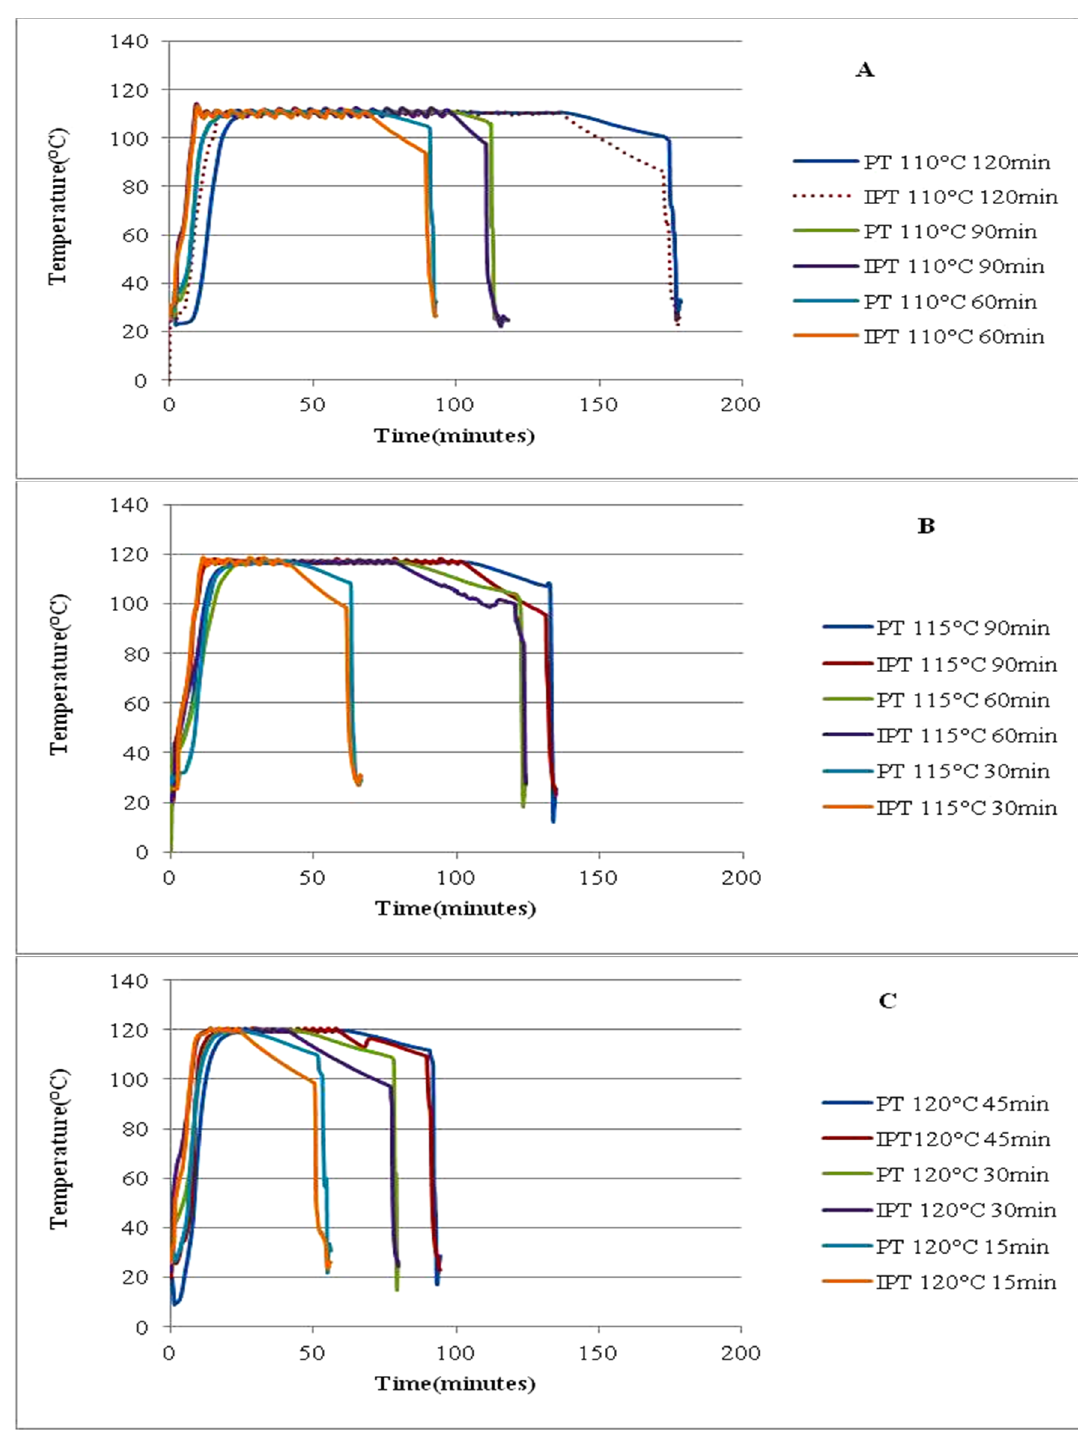
Figure 2. Time–temperature profile of thermal processing performed at ( A ) 110 ◦ C, ( B ) 115 ◦ C and ( C ) 120 ◦ C at different time